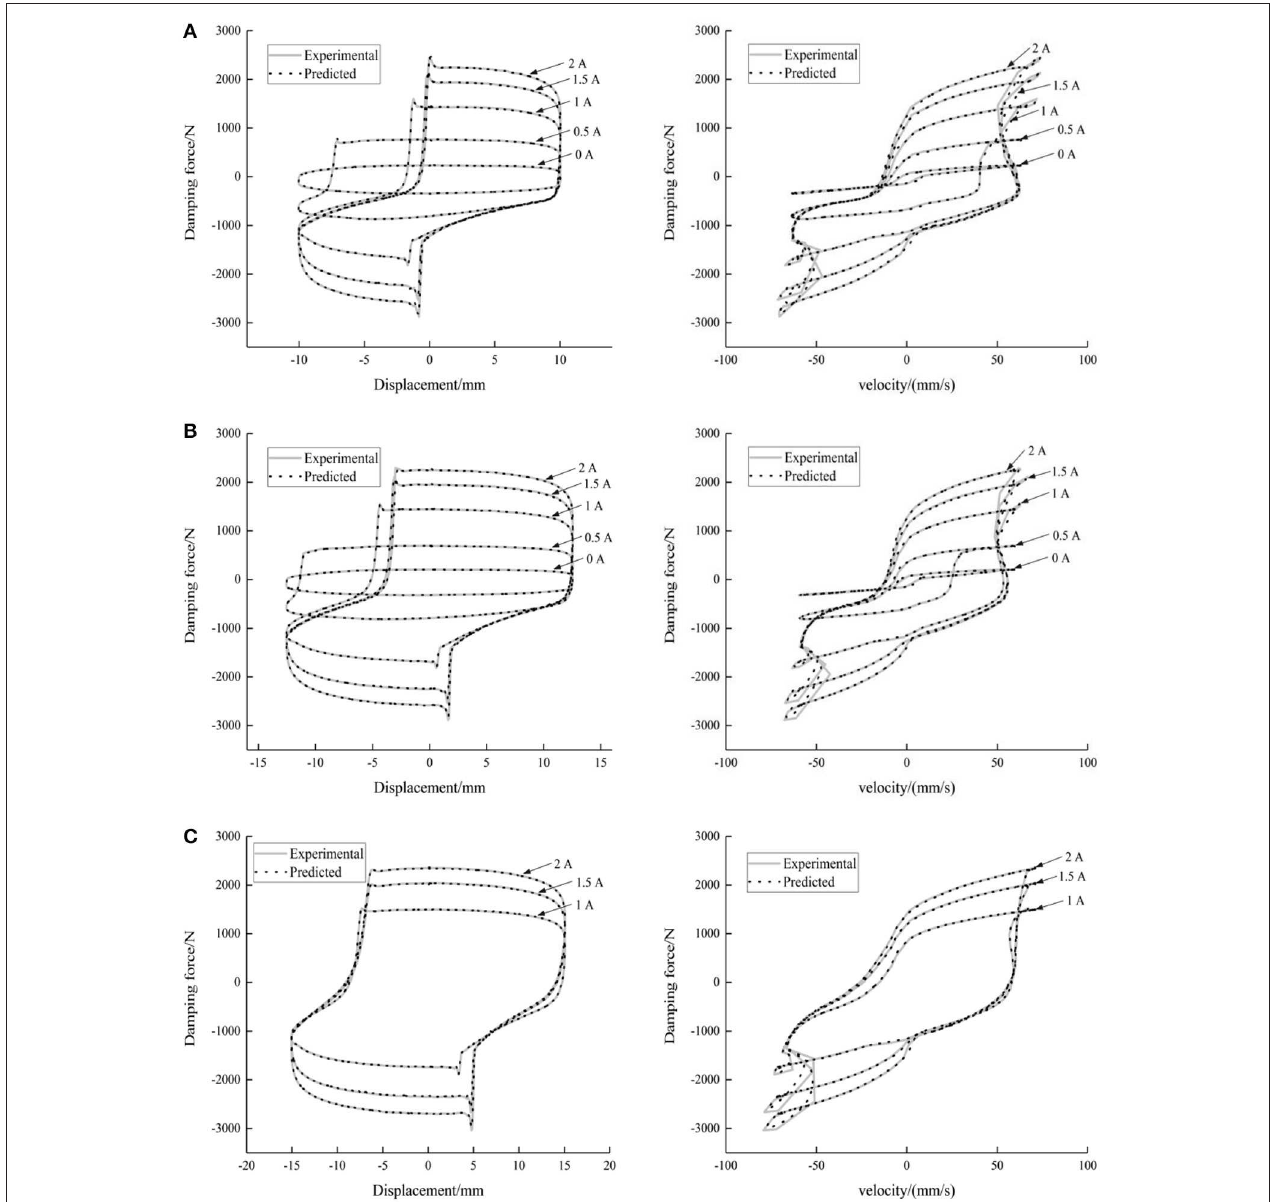
FIGURE 8 | Comparisons of the measured and predicted force–displacement and force–velocity results. (A) Test 1. (B) Test 2. (C) Test 3.